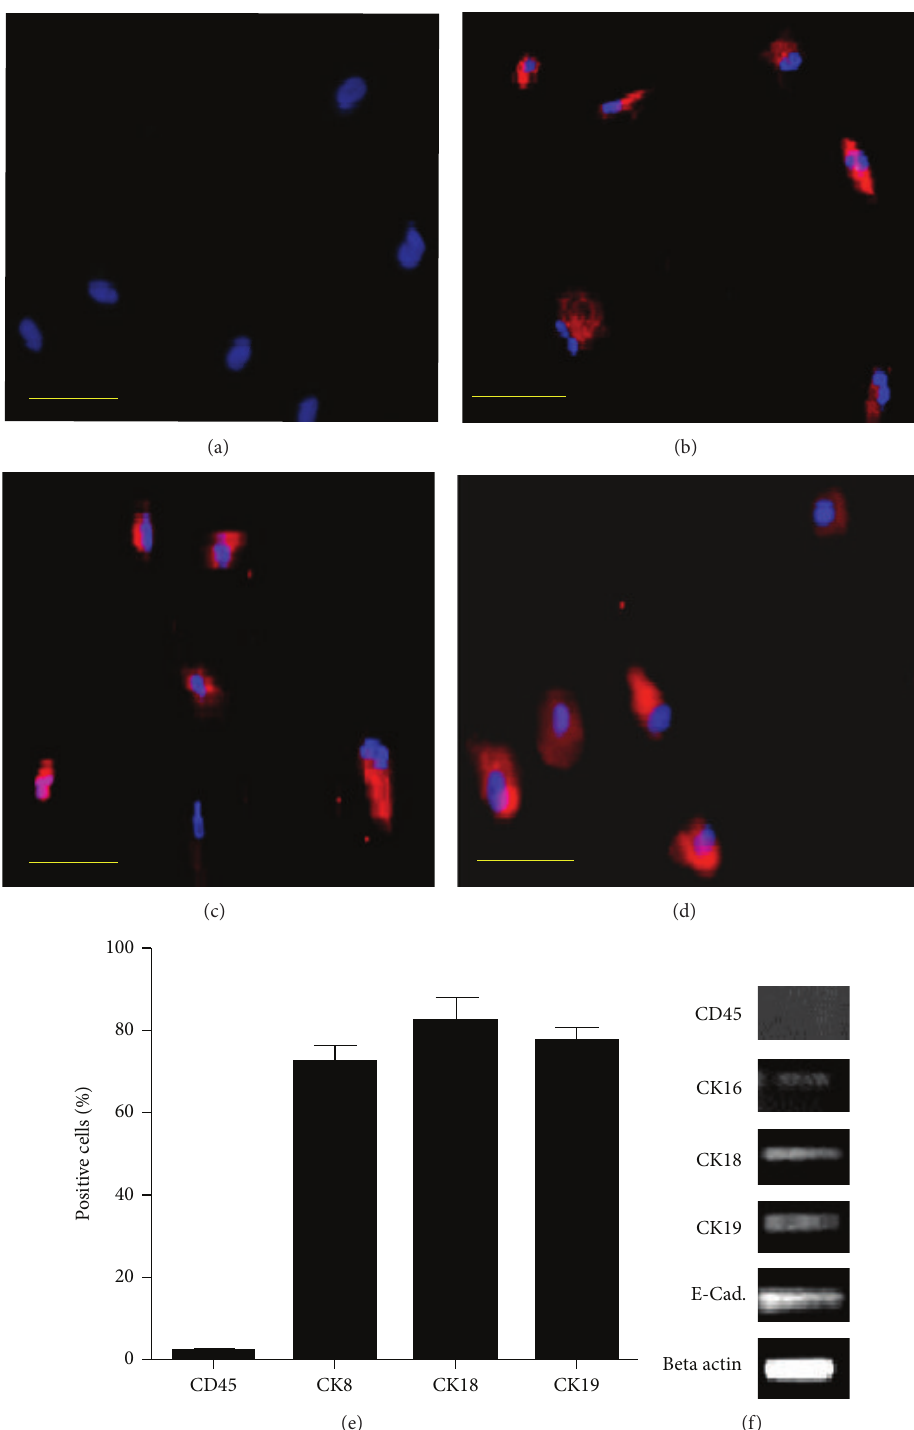
Figure 2: Immunostaining for AECs; (a) CD 45 negative. (b)–(d) CK8, CK18, and CK19 positive. (e) shows percentage of positive cells. RT-PCR for AECs; (f) CK16, CK18, CK19, and E-Cadherin